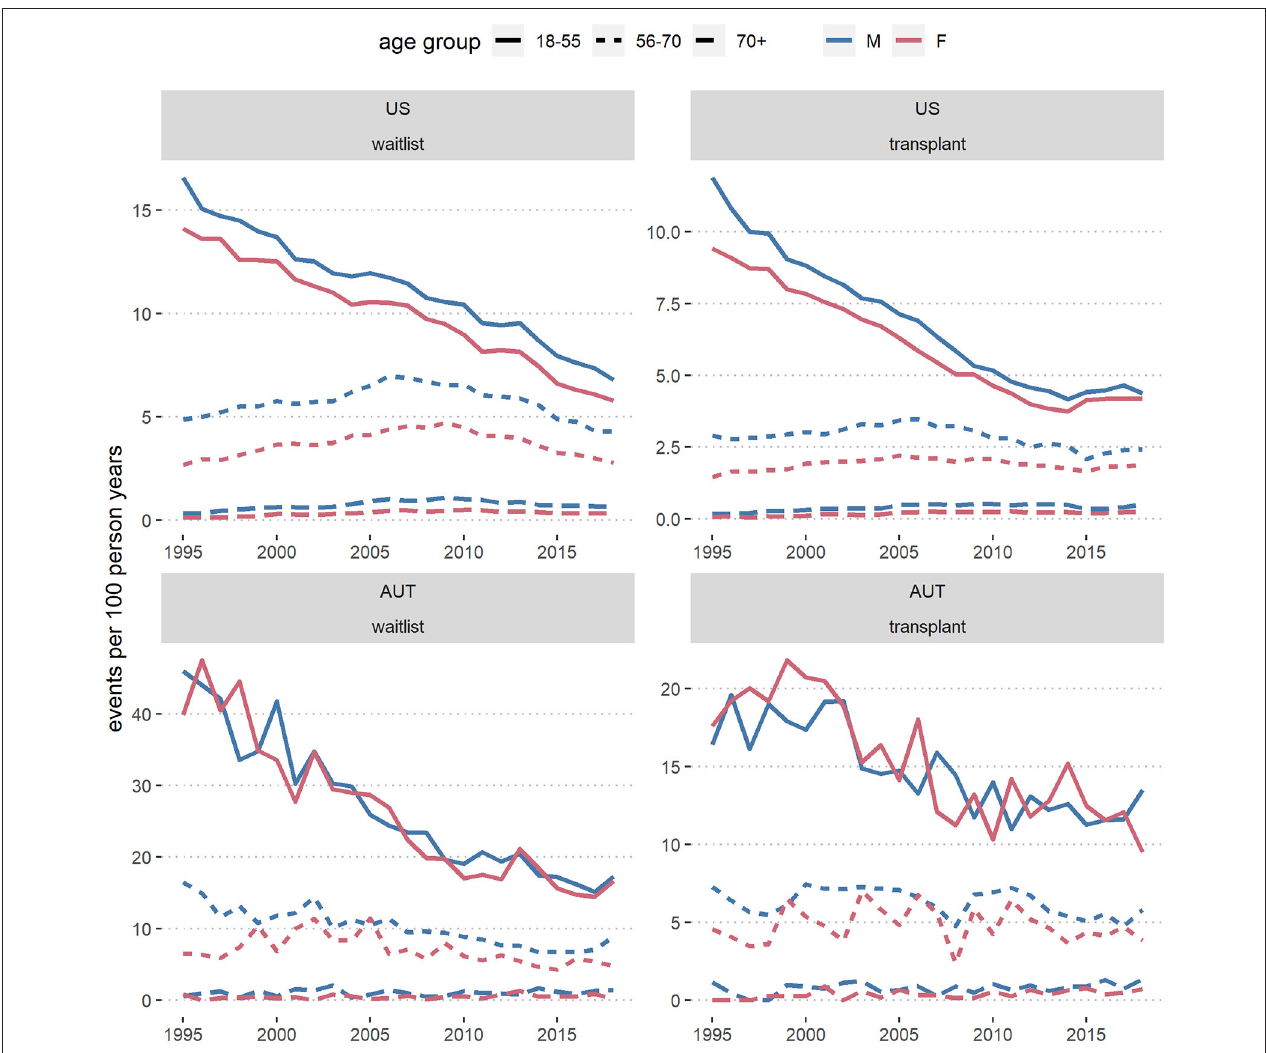
FIGURE 5 | Wait-listing and transplant rates per 100 dialysis patient years in the US and Austria (AUT), from 1995 to 2018, by sex and age group. Results are based on data from the ADTR/Eurotransplant (AUT) ( 26, 29) and USRDS (US)